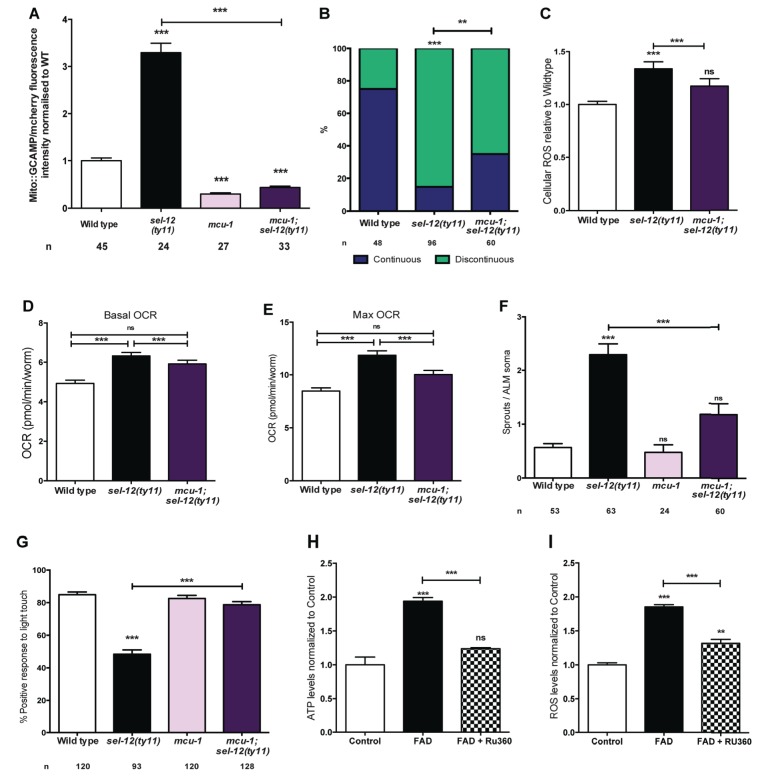
PSEN functions to regulate mitochondrial activity by mediating Ca2+ transfer from the ER to the mitochondria.(A) Quantification of mitochondrial Ca2+ using animals expressing mito::GCaMP6 and mCherry in their body wall muscle (takEx347). (B) Quantification of ALM neuronal mitochondrial morphology. Analysis was done using transgenic animals expressing mito::GFP in mechanosensory neurons (jsIs609). Data are displayed with blue and green representing the percentage of animals displaying continuous and discontinuous mitochondrial morphology, respectively. **p<0.01, ***p<0.001 (Chi-square test). (C) H2DCF-DA assay measuring ROS levels relative to wild type. Data are from three replicate assays. (D) Basal and (E) maximal respiration rates (after exposure to FCCP) of wild type, sel-12(ty11), and mcu-1;sel-12(ty11) animals. Data are from three replicate assays. (F) Quantification of aberrant neuronal structures (sprouts/branches) in ALM neurons in day one animals. ALM neuronal morphology analysis is done using transgenic animals expressing mec-4p::GFP (zdIs5). (G) Quantification of the response of day one wild type, sel-12(ty11), mcu-1;sel-12(ty11) and mcu-1 animals to light anterior and posterior touch. (H) ATP and (I) ROS levels normalized to protein content in skin fibroblasts isolated from control and FAD patients, treated with Ru360. n = number of animals analyzed per genotype. Data are displayed as mean ± SEM, and all comparisons have been made to wild type animals unless otherwise indicated). ns p>0.05, ***p<0.0001 (One way ANOVA with Tukey test).10.7554/eLife.33052.029Figure 7—source data 1.Raw data for Figure 7.